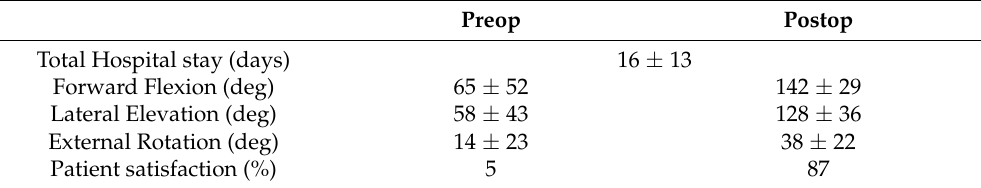
Table 3. Preliminary results on functional outcomes following a single-stage revision procedure at mean 1-year